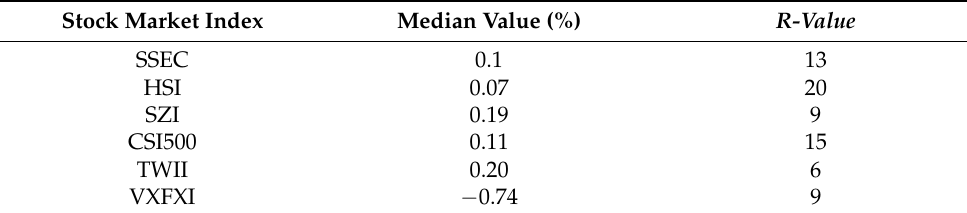
Table 1. Median values and R- value of each stock market